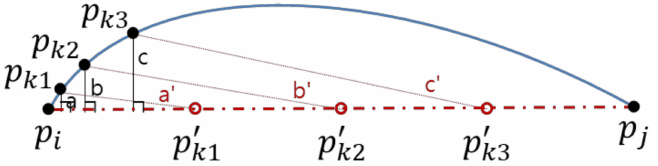
Figure 8. Measurements of perpendicular Euclidean distance ( PED) and synchronized Euclidean distance ( SED)